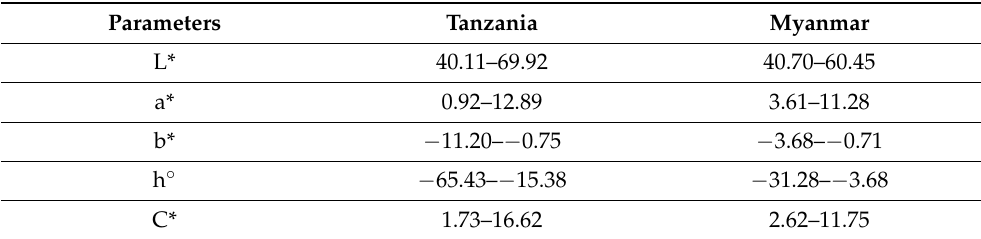
Table 3. Colorimetric coordinates L*, a*, and b* of purple spinels.